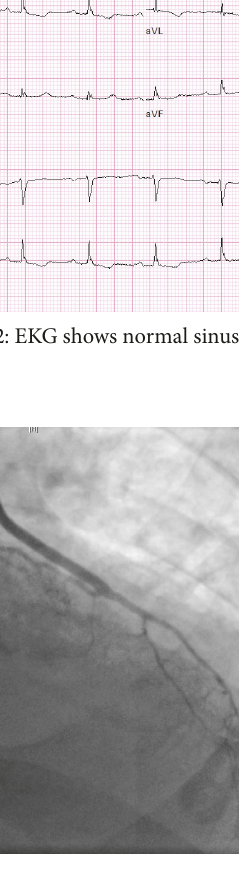
Figure 3: Angiographic view of the patent saphenous venous graft to obtuse marginal branch.